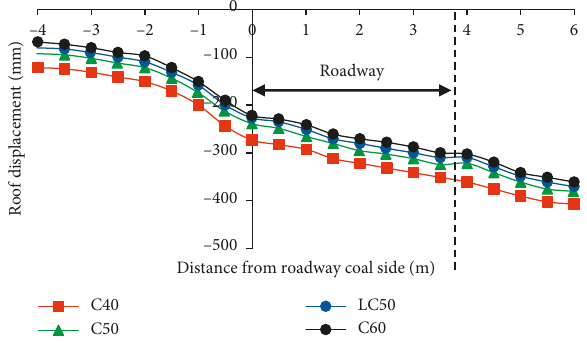
Figure 23: Displacement curve of the roof.